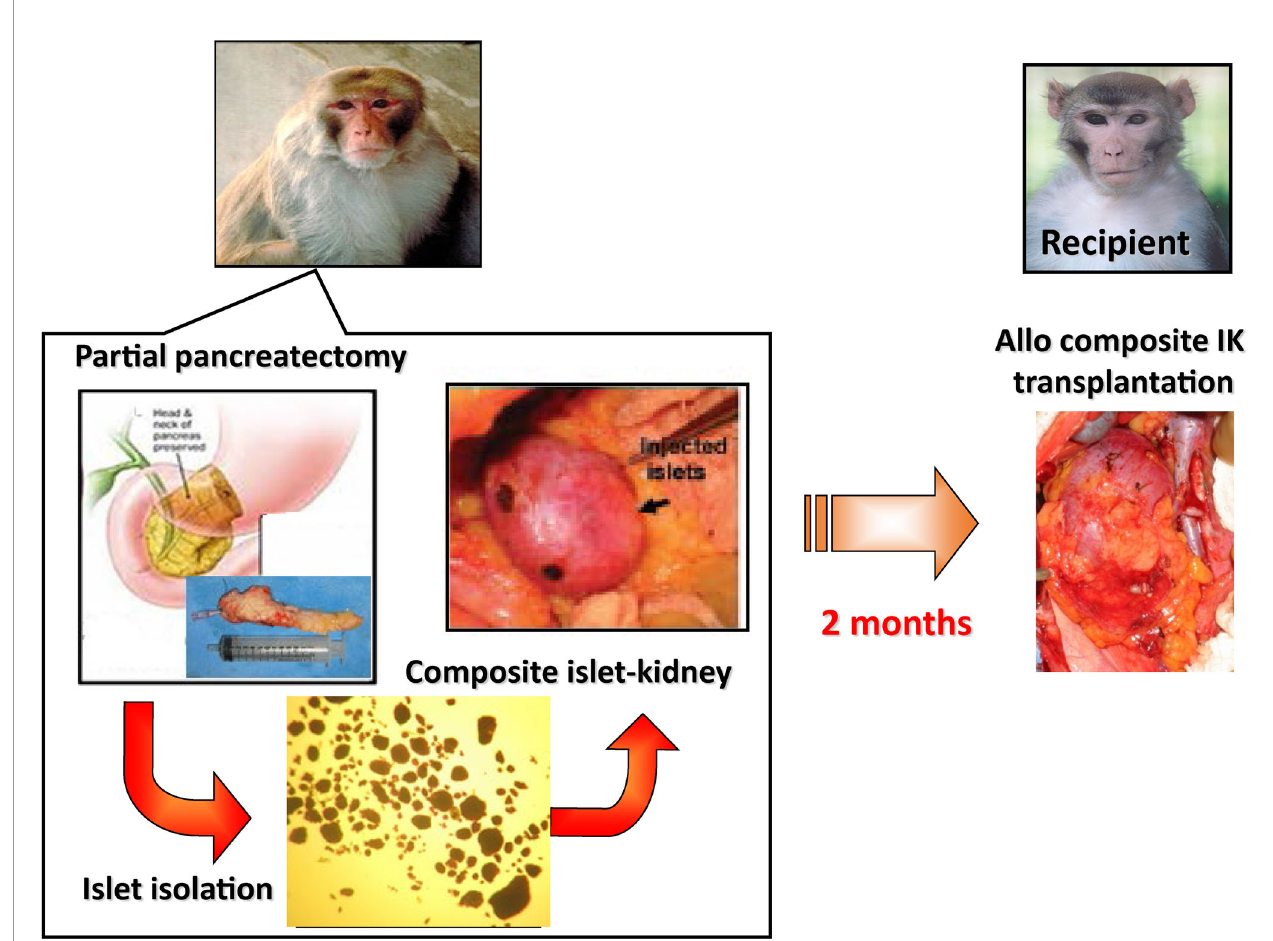
FIGURE 1 | Schematic diagram of preparation of a composite islet-kidney (I-K) graft in a donor and allogeneic composite I-K